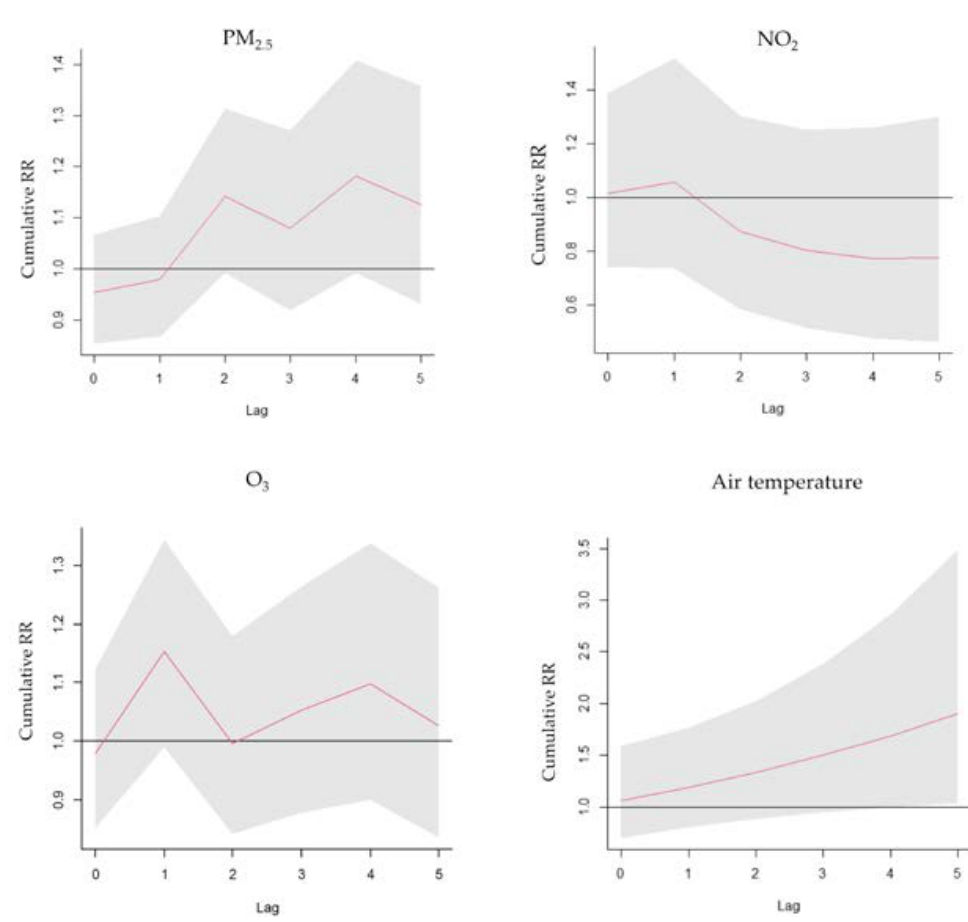
Figure 4. Lag−response curve of the cumulative effects of PM 2.5 , O 3 , NO 2 and air temperature. Figure 4. Lag − response curve of the cumulative effects of PM 2.5 , O 3 , NO 2 and air Table 1. The asthma emergency room visits, air pollutants and meteorological factors in Longtan district over 4 years (2016–2019).